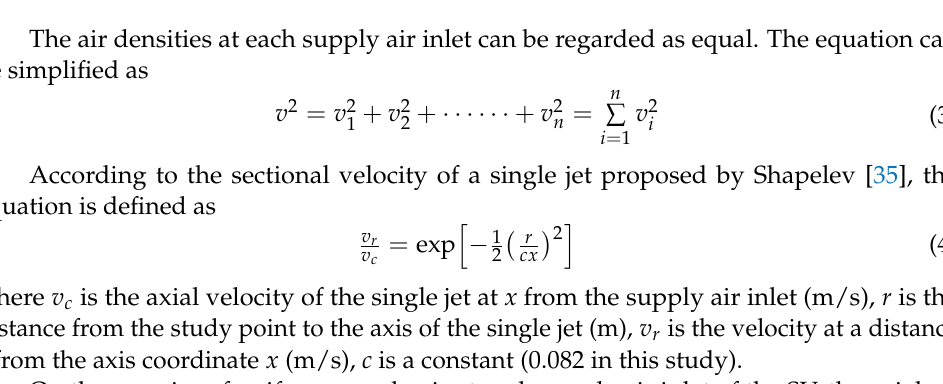
Figure 3. Multiple parallel jets.